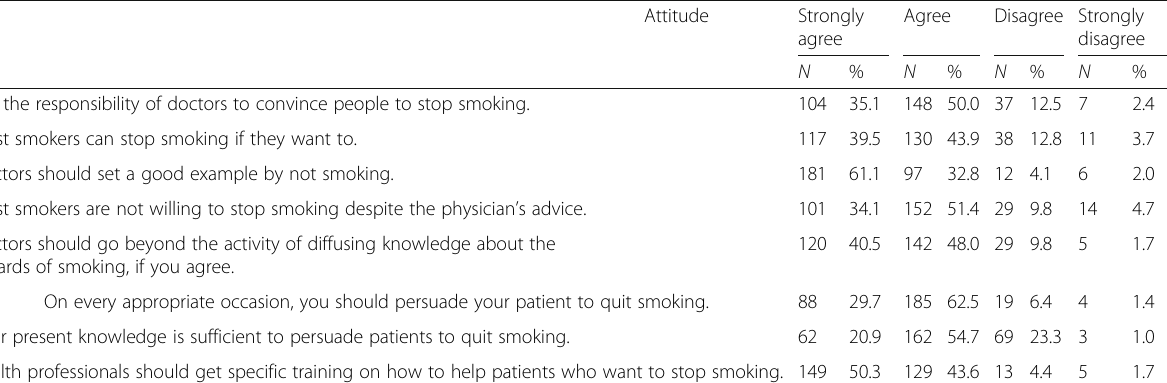
Table 3 Attitudes of students regarding the role of physicians in combating smoking and the sufficiency of their